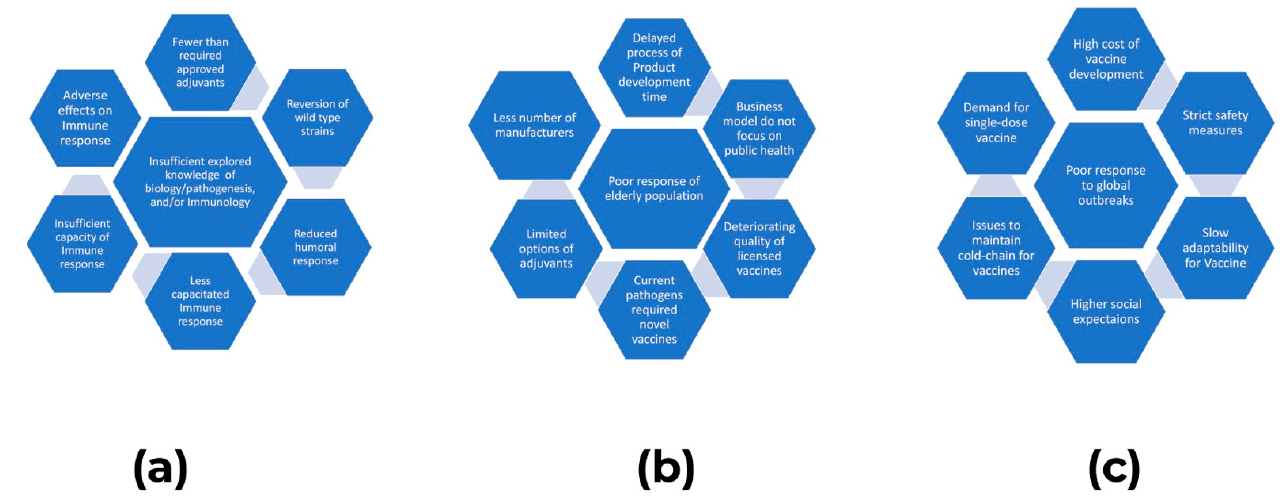
Figure 1. An overview ( a – c ) of the challenges in vaccine development and applications [5].